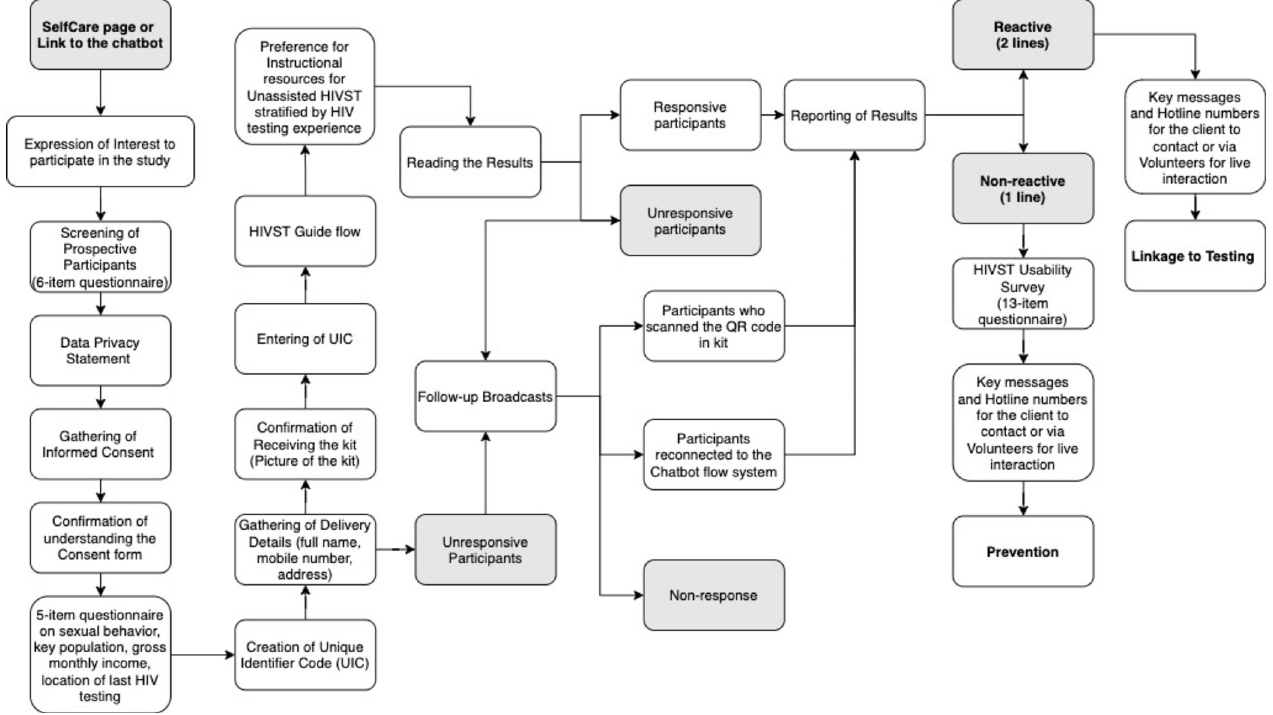
Fig 1. Virtual assistant flow for unassisted